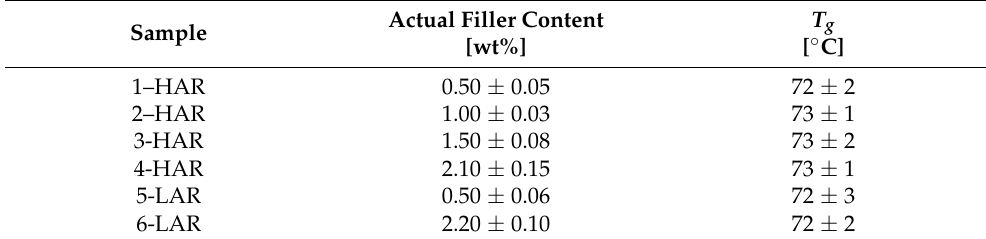
Table 2. Results of thermal analyses conducted on PVB/GNPs